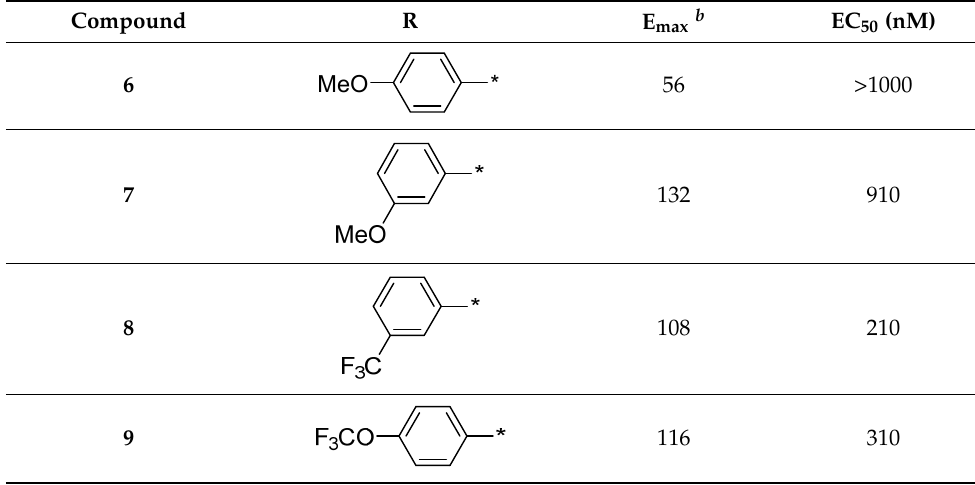
Table 1. Agonistic activity of 2-(4 H -1,2,4-triazol-3-yl)ethan-1-amine analogs 6 – 57 of screening hit Table 1. Agonistic activity of 2 ‐ (4 H ‐ 1,2,4 ‐ triazol ‐ 3 ‐ yl)ethan ‐ 1 ‐ amine analogs 6 – 57 of screening hit Table 1. Agonistic activity of 2 ‐ (4 H ‐ 1,2,4 ‐ triazol ‐ 3 ‐ yl)ethan ‐ 1 ‐ amine analogs 6 – 57 of screening hit Table 1. Agonistic activity of 2 ‐ (4 H ‐ 1,2,4 ‐ triazol ‐ 3 ‐ yl)ethan ‐ 1 ‐ amine analogs 6 – 57 of screening hit Table 1. Agonistic activity of 2 ‐ (4 H ‐ 1,2,4 ‐ triazol ‐ 3 ‐ yl)ethan ‐ 1 ‐ amine analogs 6 – 57 of screening hit compounds 1 – 2 with respect to TAAR1 receptor. a. compounds 1 – 2 with respect to TAAR1 receptor a . Table 1. Agonistic activity of 2 ‐ (4 H ‐ 1,2,4 ‐ triazol ‐ 3 ‐ yl)ethan ‐ 1 ‐ amine analogs 6 – 57 of screening compounds 1 – 2 with respect to TAAR1 receptor. a. compounds 1 – 2 with respect to TAAR1 receptor. a.